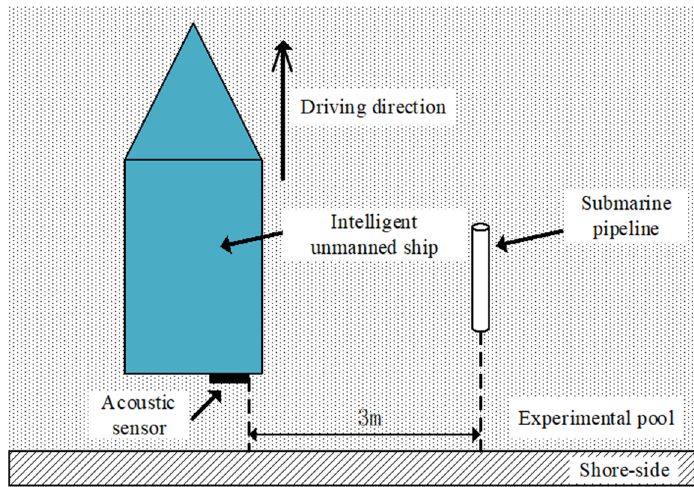
Figure 12. Schematic diagram of the experimental process.